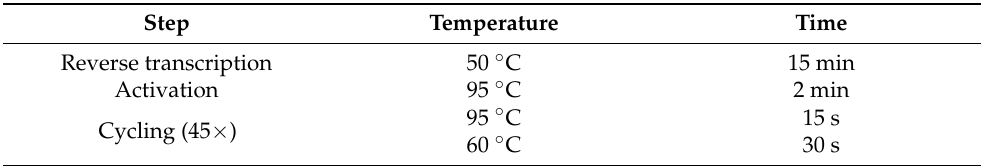
Table 1. Cycling conditions for the ISG RT-PCR-based